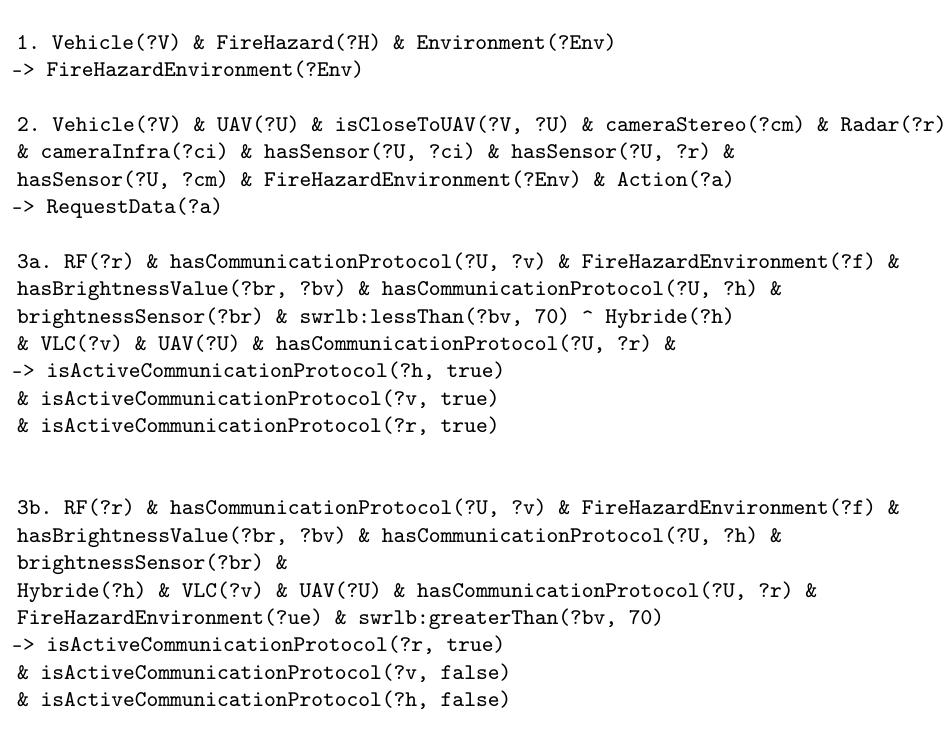
Figure 13. Set of rules for the management of an obsctructed view.